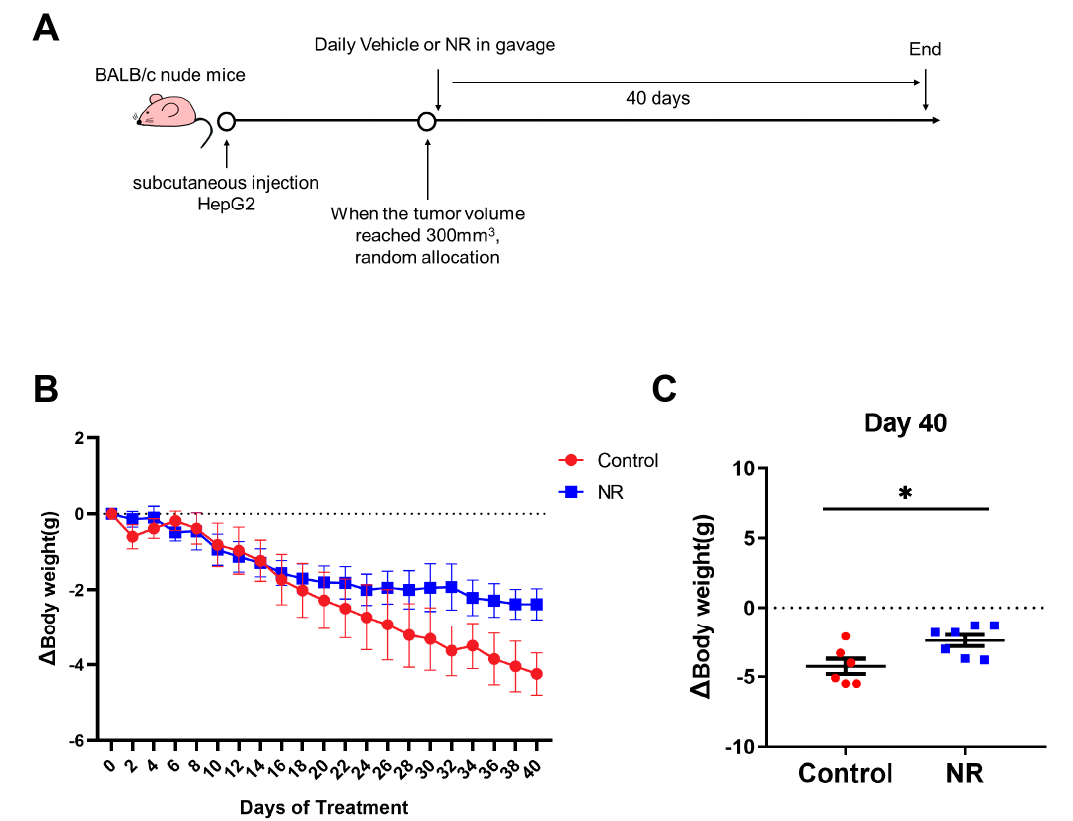
Figure 2. NR supplementation alleviated malignancy-induced weight loss in mice. ( A ) Schematic of the subcutaneous xenograft model. ( B ) Changes in weight loss of the mice during the intervention. ( C ) Differences in weight loss among two groups after 40 days of intervention. n = 6–7/group; * p < 0.05 compared to the control group. Dotted line represented the line (y = 0). Red dots: control mice; blue dots: NR-treated mice. p -values were calculated using two-way RM ANOVA test ( B ) and unpaired t test ( C ). NR, nicotinamide riboside.